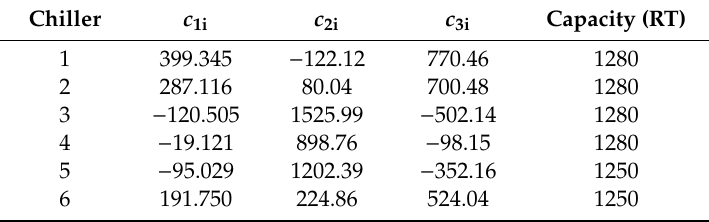
Table 1. Chiller data in case